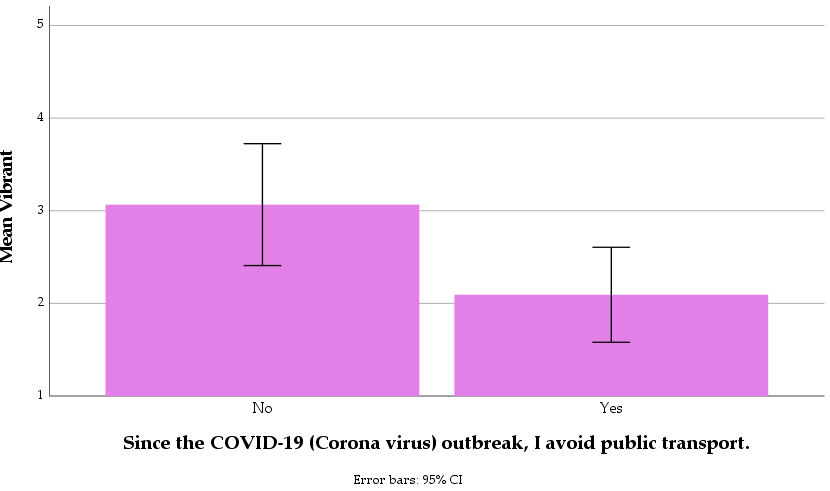
Figure 7. Mean scores for the soundscape attribute “Vibrant” between the two groups avoiding/not- avoiding public transport because of COVID-19.